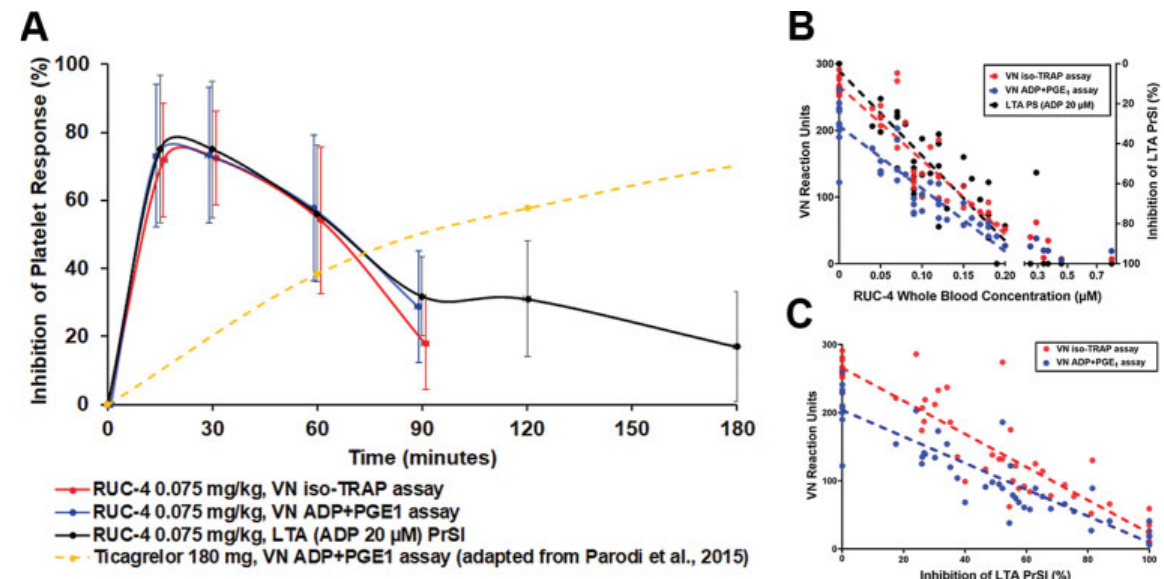
Fig. 3 Inhibition of platelet function measured by the VN iso-TRAP and ADP þ PGE 1 assays of citrate-anticoagulated blood and ADP-induced LTA of PPACK-anticoagulated blood after RUC-4 subcutaneous administration to humans, and comparison with effect of ticagrelor after oral administration of crushed tablets to STEMI patients reported by Parodi et al., J Am Coll Cardiol 2015; 65: 511 – 512 (data extracted from fi gure using WebPlotDigitizer). ( A ) Inhibition of platelet responses as a function of time after administration of either RUC-4 (mean (cid:4) SD; n ¼ 11, 50 measurements) or ticagrelor (VN ADP þ PGE 1 ; n ¼ 41). ( B ) RUC-4 whole blood concentration versus VN reaction units (left axis) and inhibition of ADP (20 µM)-induced LTA PrSl (right axis) (linear regression lines: iso-TRAP assay: R 2 ¼ 0.83; p < 0.001; ADP þ PGE 1 assay: R 2 ¼ 0.81; p < 0.001; LTA: R 2 ¼ 0.83; p < 0.001. ( C ) Inhibition of LTA PrSl versus VN reaction units (linear regression lines: iso-TRAP assay: R 2 ¼ 0.84, p < 0.001; ADP þ PGE 1 assay: R 2 ¼ 0.83; p < 0.001). VN ¼ VerifyNow; LTA ¼ Light transmission aggregometry; PrSl ¼ Primary slope; PRP ¼ Platelet- rich plasma.